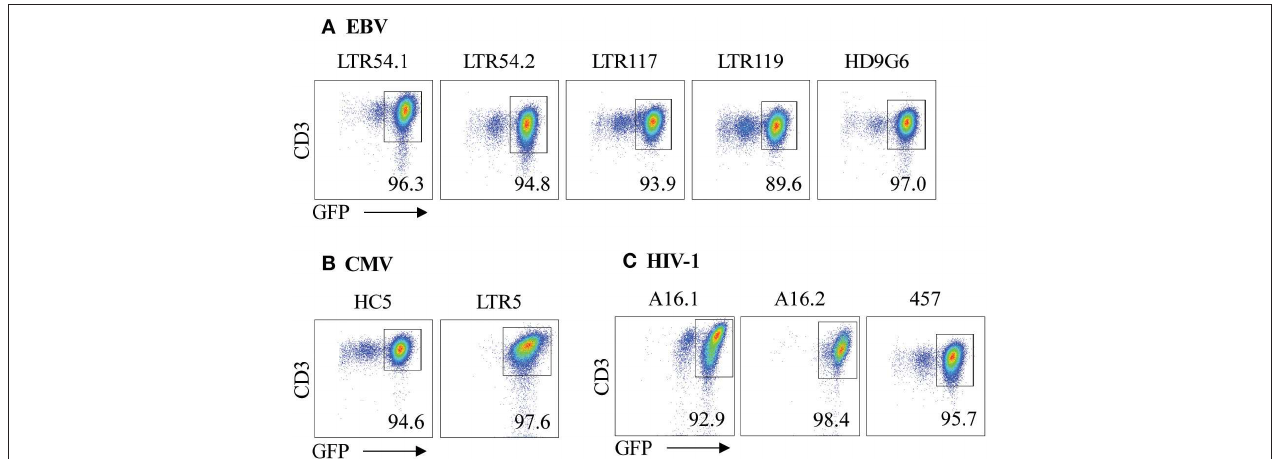
FIGURE 3 | αβ TCR expression of SKW3 reporter cells. Retrovirally transduced SKW3 cells expressing cross-reactive virus-specific αβ TCRs for (A) EBV, (B) CMV, and (C) HIV-1 were monitored for stable cell surface TCR expression. Cells were gated on FSC vs. SSC, single cells, GFP + CD3 + cells. Representative plots are shown.